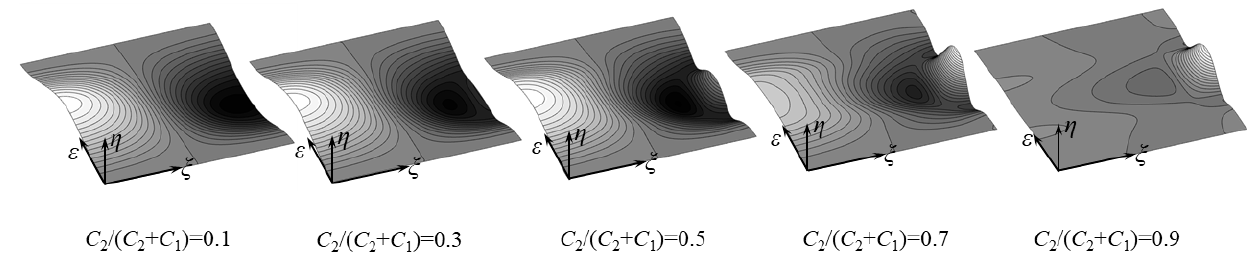
Figure 4. The effect of weight factor on the end wall contouring.